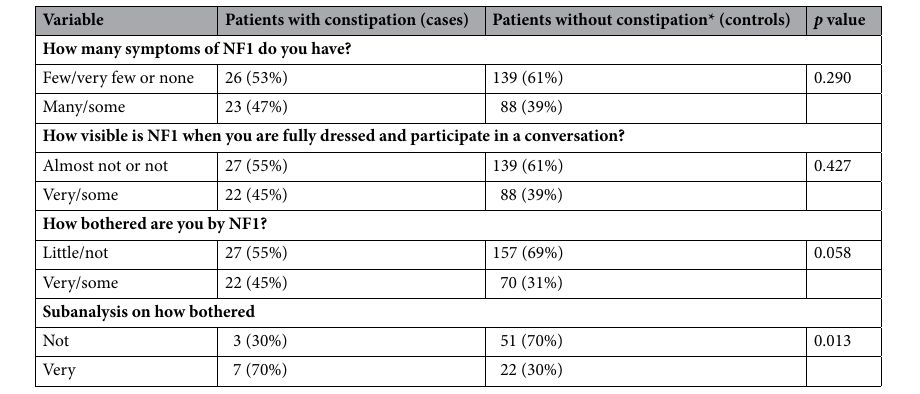
Table 2. Self-perceived perception of NF1 in 276 patients. *Data missing in one